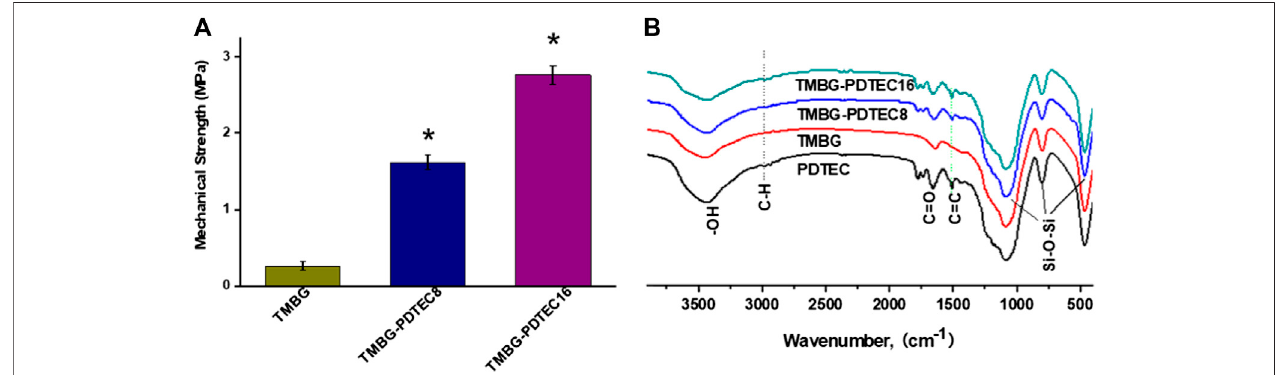
FIGURE3| MechanicalpropertyandFTIRspectraofthescaffolds: (A) thecompressivestrengthand (B) Fouriertransforminfrared(FTIR)spectroscopypatternsof prepared TMBG, TMBG-PDTEC8, and TMBG-PDTEC16 scaffolds. (* p < 0.05 compared to TMBG) ( n (cid:2) 5).